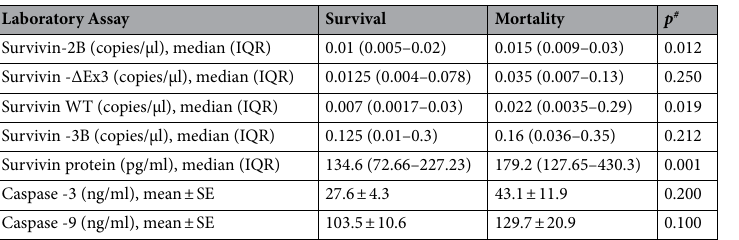
Table 2. Survivin’s expression and caspases serum levels related to mortality. WT wild type, SIRS systematic inflammatory response syndrome.